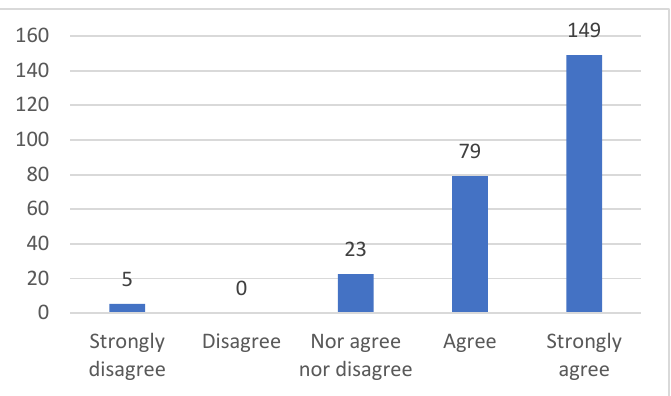
Figure 10. Answers to question 1: The assessment of mathematical contents is positive.